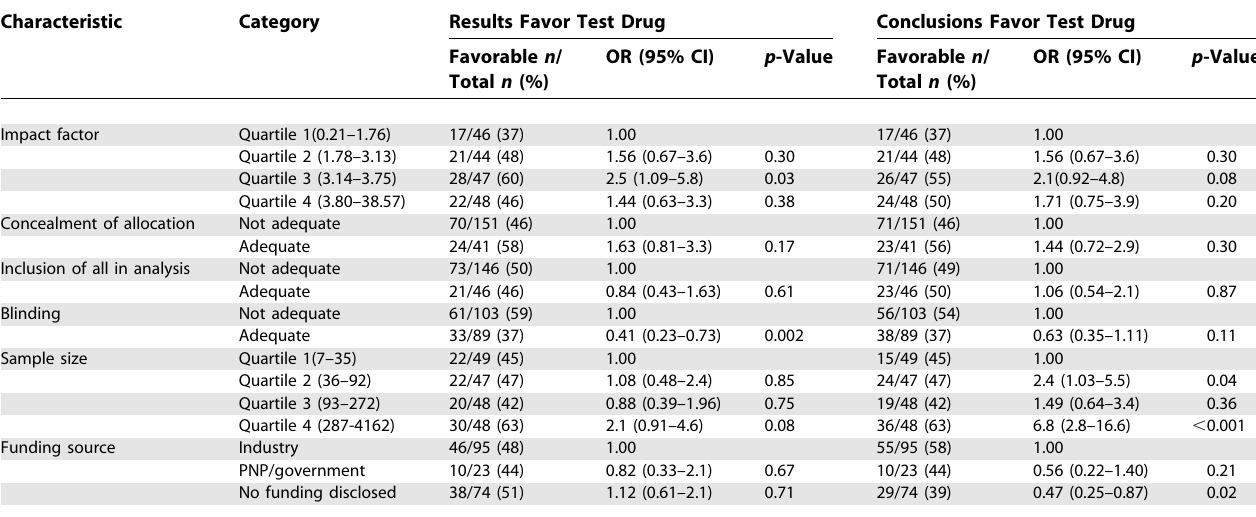
Table 2. Association between Characteristics of Articles ( n ¼ 192) and Statistically Significant Results or Conclusions that Favor the Test Drug: Univariate Logistic Regression